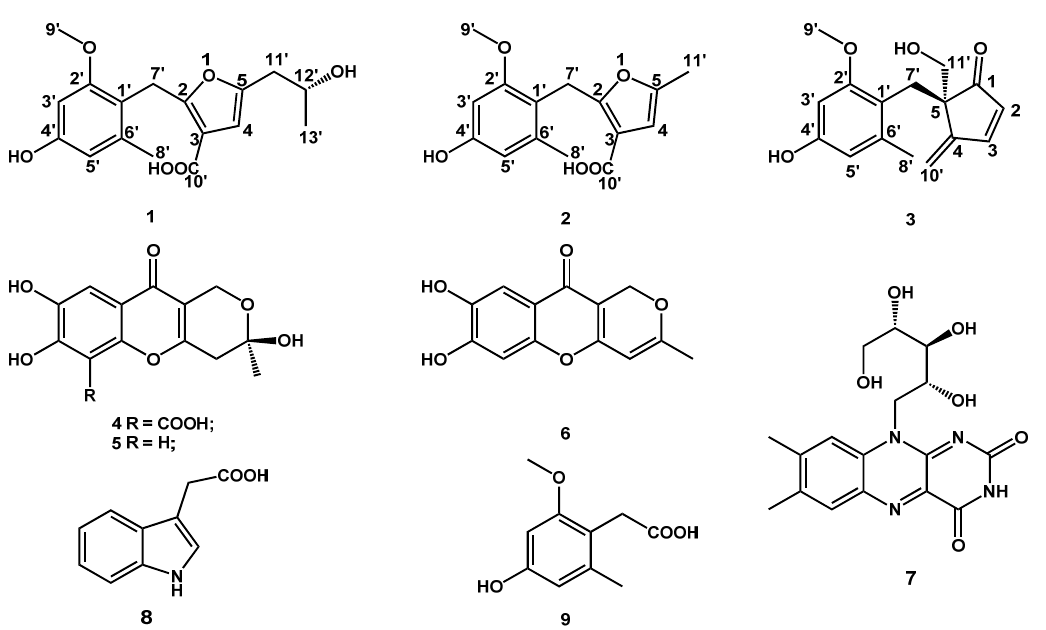
Figure 1. Chemical structures of compounds 1 – 9.